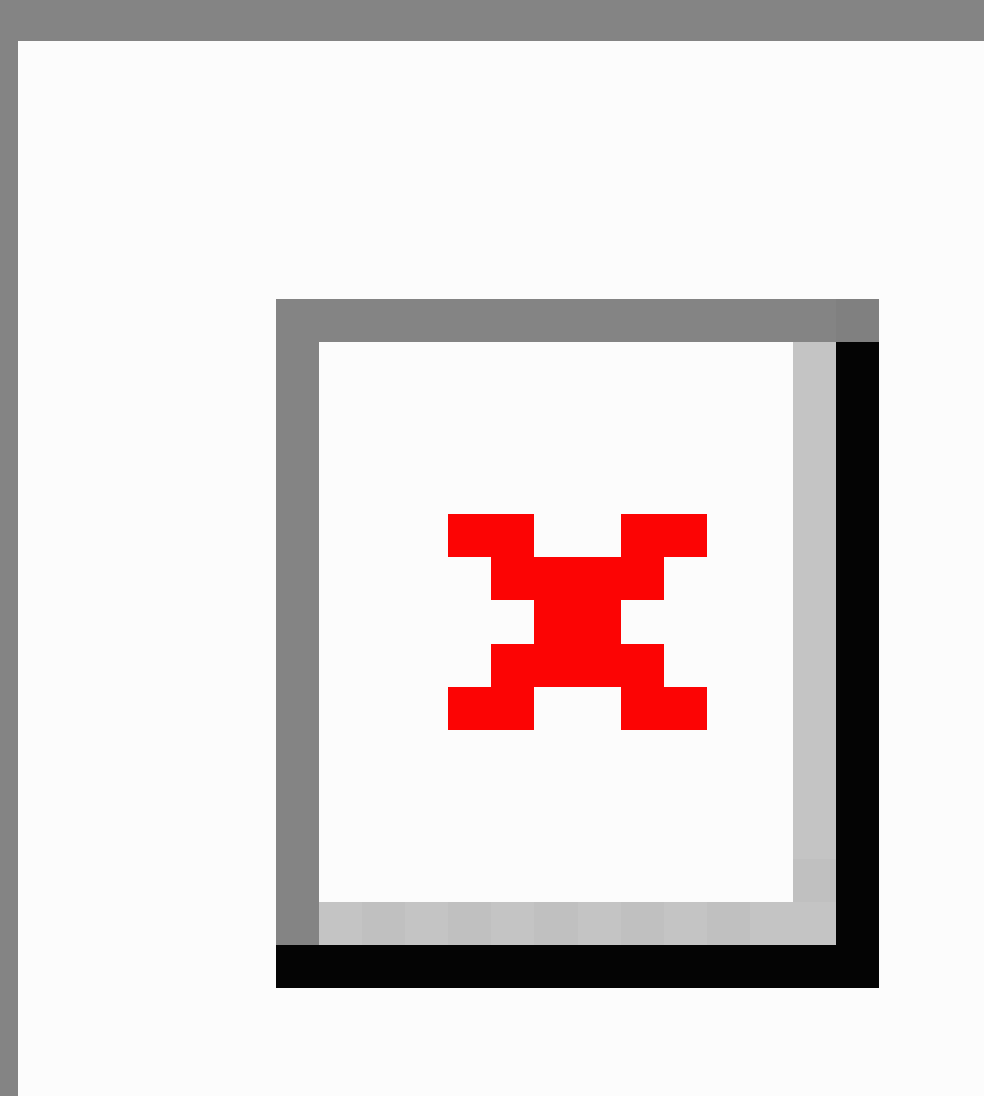
Figure 4. Screenshot of the [No Smoke Guide] app by the Korean Ministry of Health and